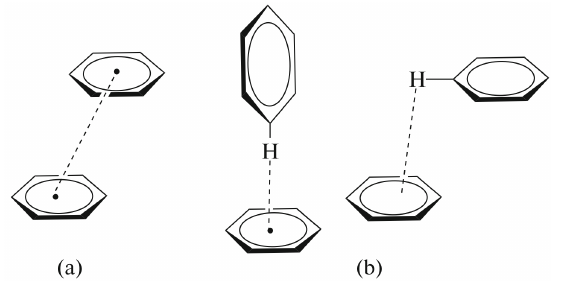
Figure 2. Geometry of weak directional stacking interactions ( a ) and the C-H · · · π system ( b ). Reprinted from [147], with permission from Springer